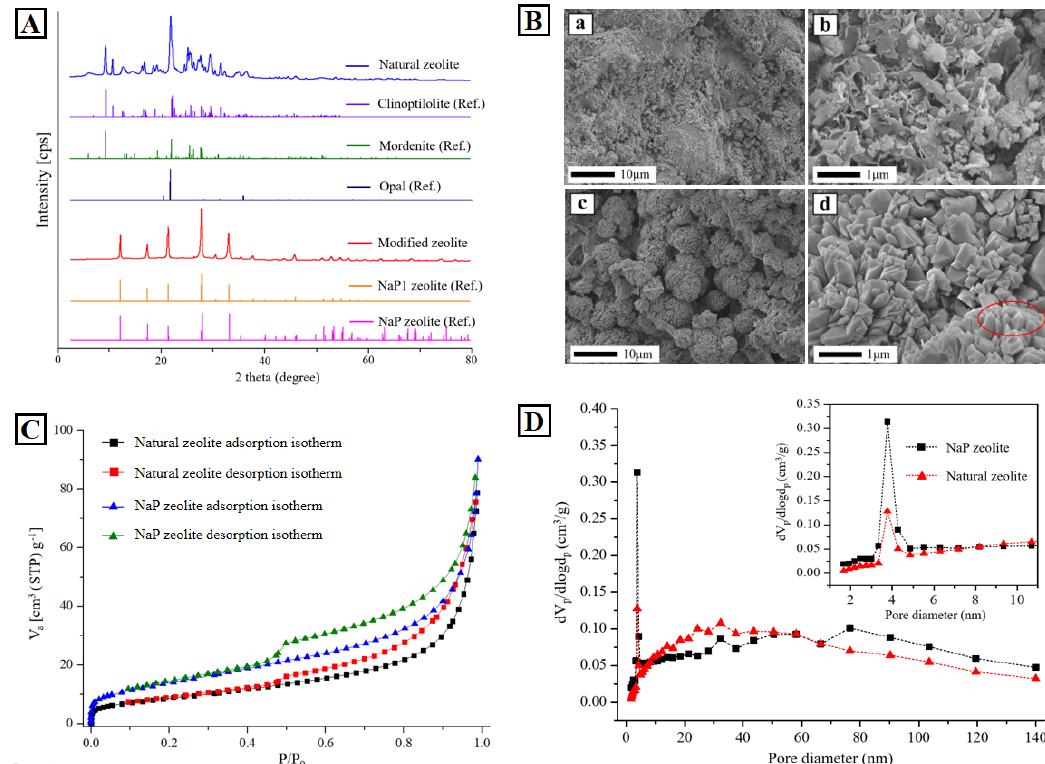
Figure 2. Characterization of granular-sized natural zeolite and NaP zeolite. ( A ): XRD patterns with known references; ( B ): SEM images of natural zeolite ( a , b ) and NaP zeolite ( c , d ) at different magnifications; ( C ): N 2 adsorption/desorption isotherms; and ( D ): BJH pore size distribution obtained from the desorption branch.